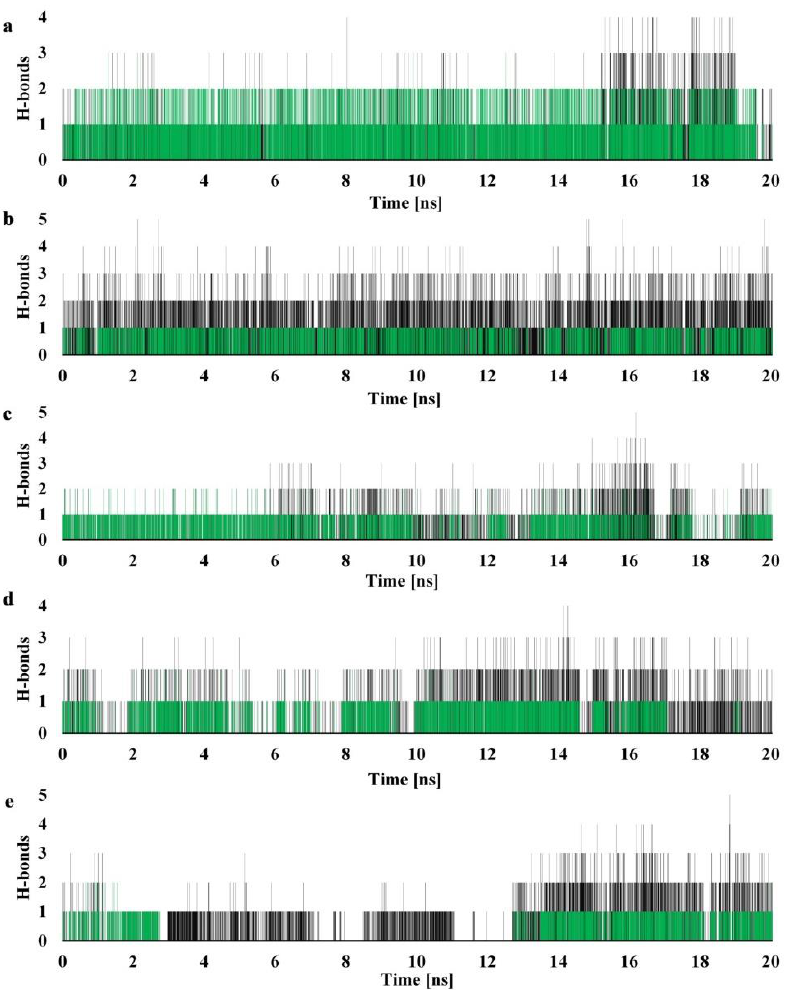
Figure 9. Number of H-bonds detected during 20 ns molecular dynamics simulation for ( a ) 2 , ( b ) 6 , ( c ) 13 , ( d ) 14 , and ( e ) 16 . Cut-off distance for H-bonds was set to 3.2 Å and 30° angle. Green indicates interactions with Glu-30.